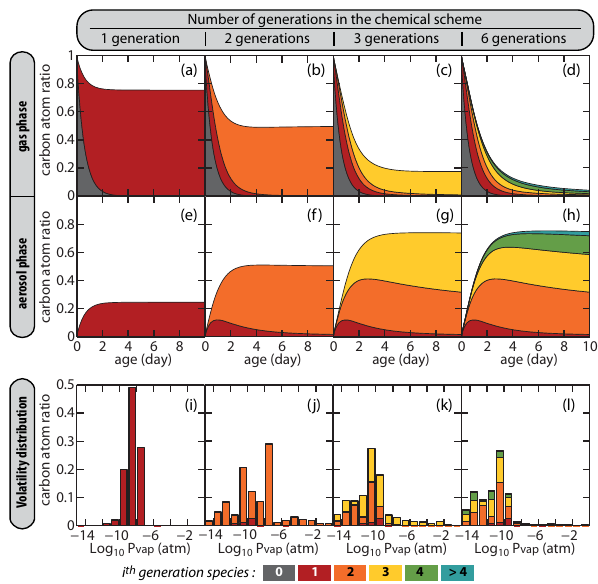
Figure 2: Partitioning of organic carbon during hexadecane oxidation in the gas phase (1 st row) and the aerosol phase (2 nd row) and volatility distribution of the species (3 rd row) given on logarithmically spaced bins. The number of successive generations taken into account in the gas ‐ phase mechanism varies from 1 (1 st column) to 6 (4 th column). Colors identify the contribution of the species from a given generation to the total carbon budget.